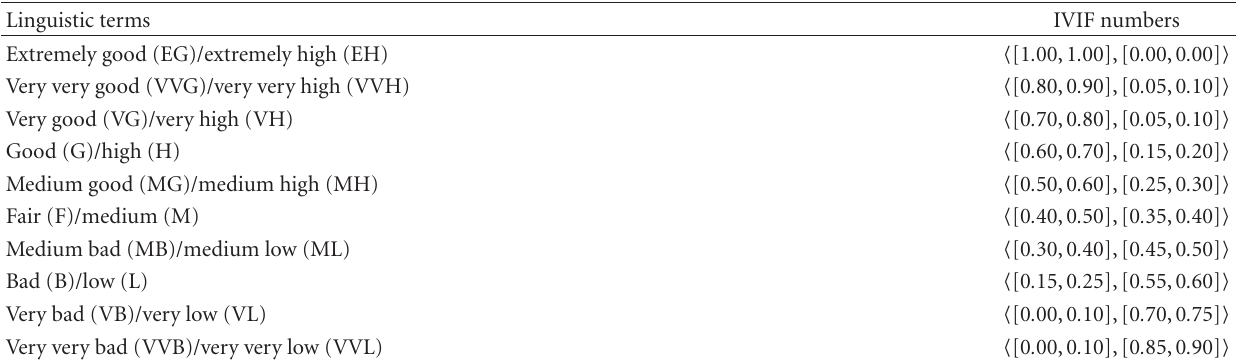
Table 4: Linguistic terms for rating the alternatives.